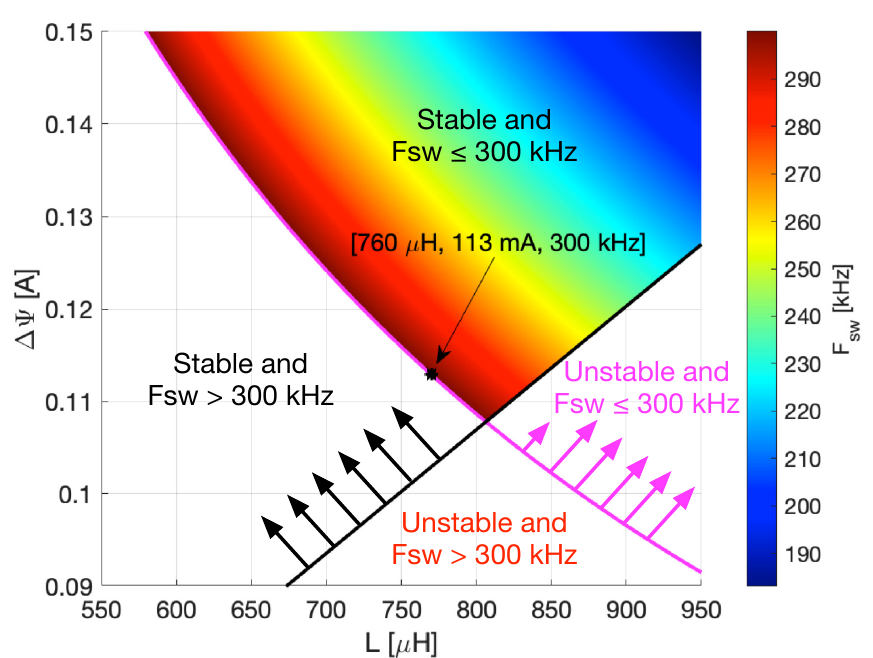
Figure 10. Design of the inductor L and hysteresis band ∆Ψ